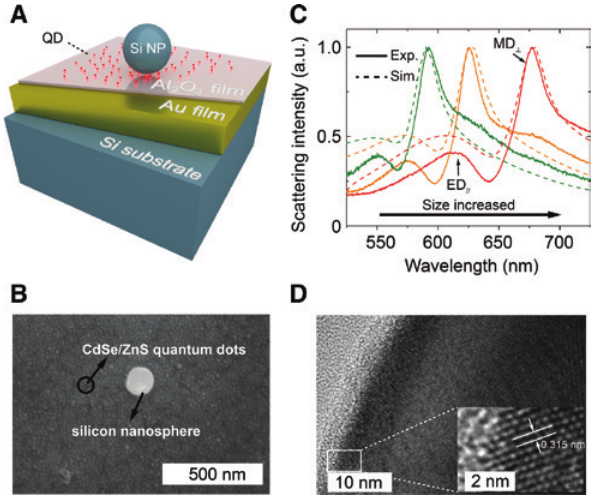
Figure 1: Silicon nanosphere on metal film nanoantenna. (A) Schematic of the SiNPoM antenna. (B) SEM image of a SiNPoM antenna with the quantum dots monolayer in the gap. (C) Measured (solid) and simulated (dashed) dark-field scattering spectra of SiNPoM antennas (with 5 nm Al O layer) with different diameters 2 3 of 162 nm (green), 174 nm (yellow) and 190 nm (red), where the resonances are red-shifted with the increase of the SiNP size. (D) High-resolution TEM image of a SiNP, reflecting the